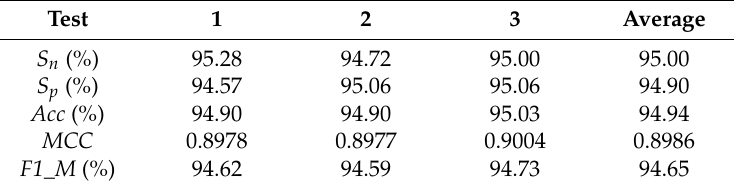
Table 6. The results of three different cross-validation tests.